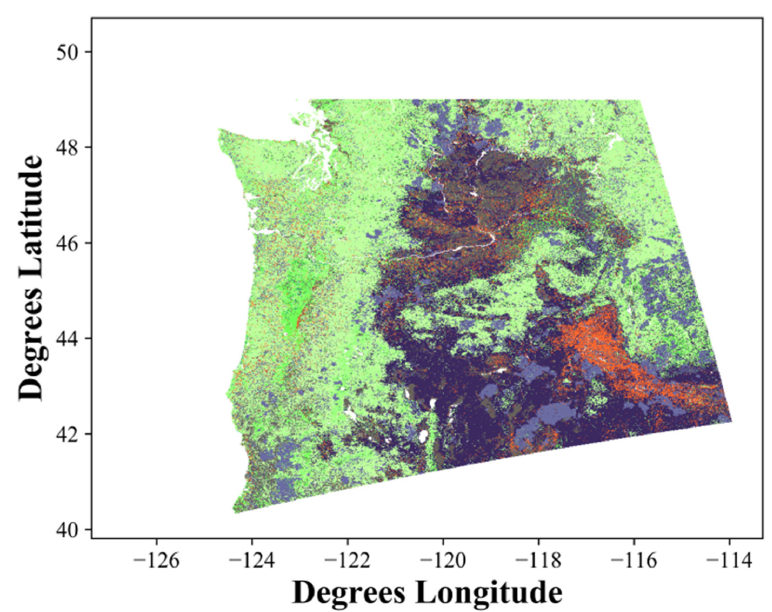
Figure 11. National Vegetation Classification (NVC) vegetation Groups within the Pacific Northwest (NW). A total of 81 vegetation types in the NW are represented in this image. Note that coloration has been simplified and uses LANDFIRE color classes (https://landfire.gov/CSV/NVC.csv, accessed 11 June 2019).